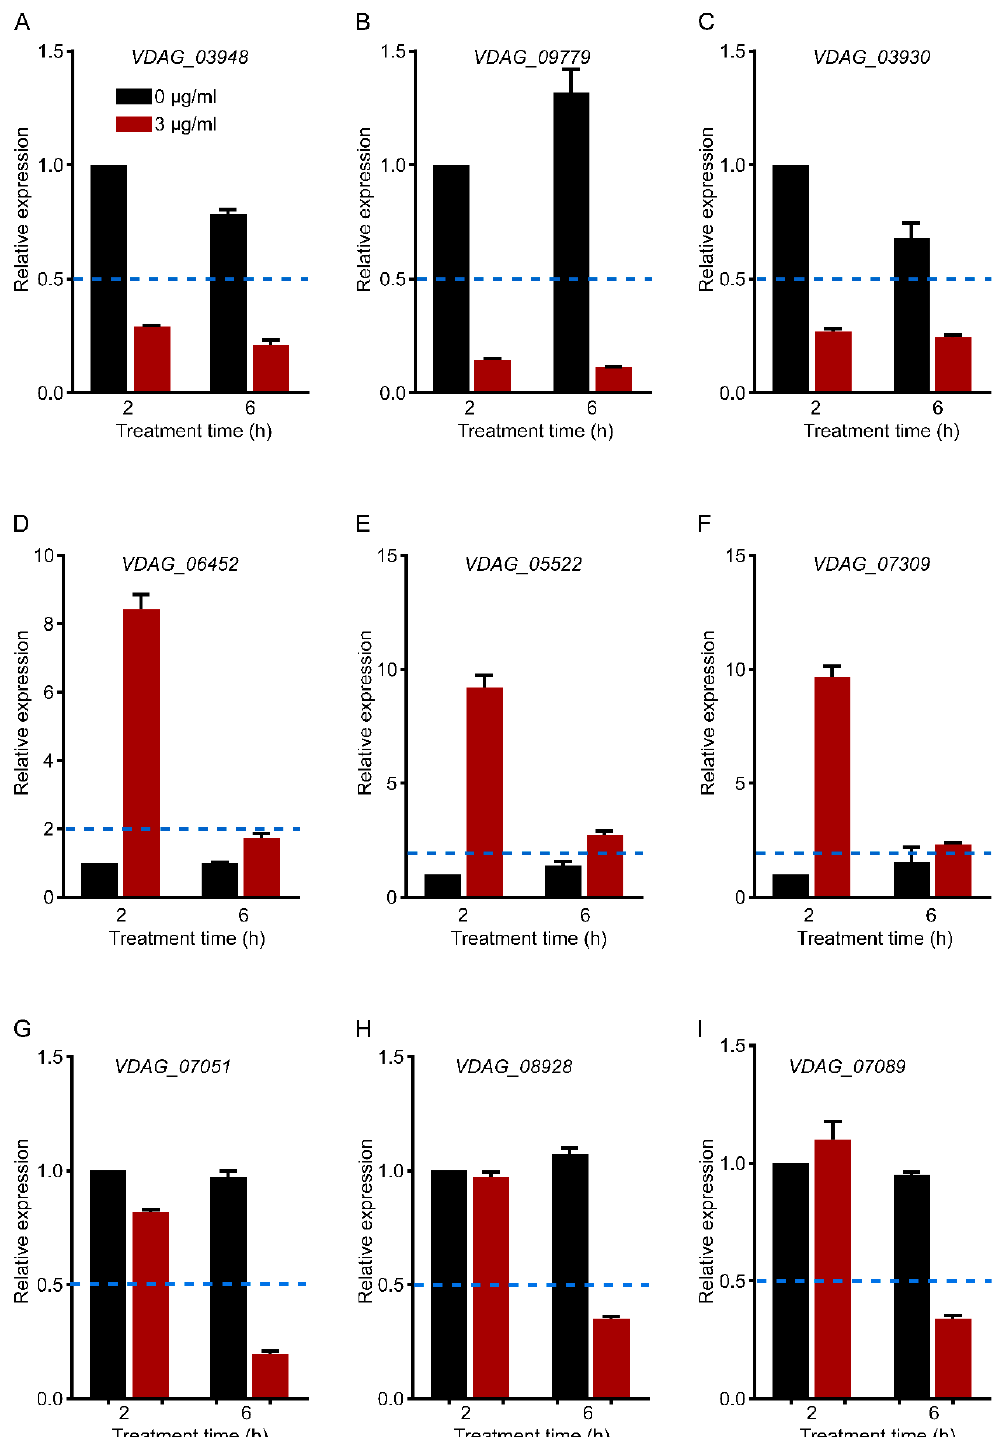
Figure 8. qRT ‒ PCR verification of gene expression ( A – C ). Cell-wall-related genes (2–h and 6–h com- mon DEGs). ( D – F ). Hydrolase-activity-related genes (2–h specific DEGs). ( G – I ). Translation-related